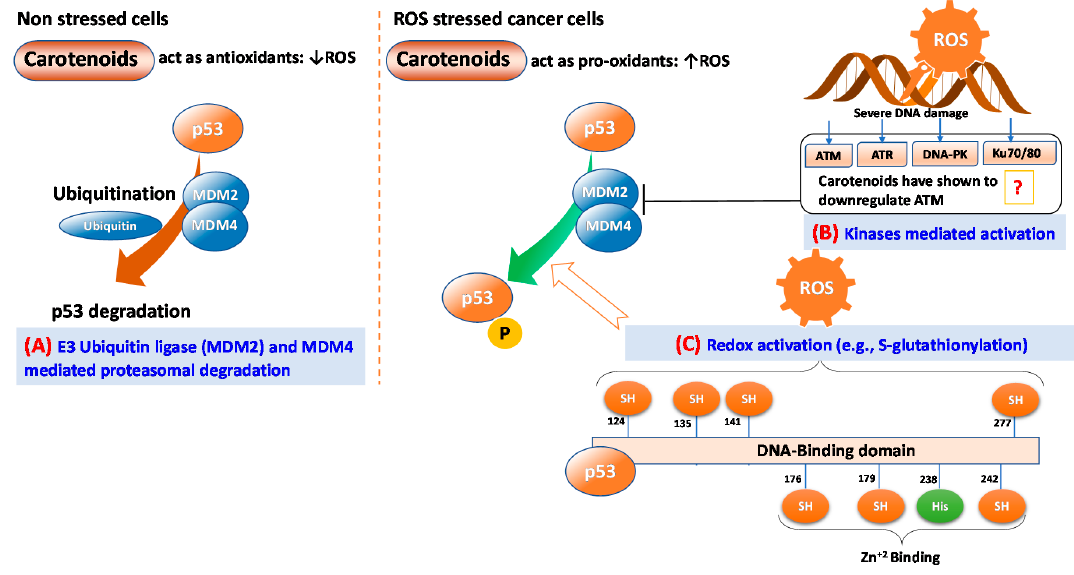
Figure 4. Major routes of p53 activation triggered by carotenoids-mediated reactive oxygen species (ROS)-induced. ( A ) E3 ubiquitin ligases MDM2 and MDM4 mediated proteasomal degradation in non-stress cells; ( B ) Kinases-mediated activation in cancer cells, and ( C ) Direct redox activation by S - glutathionylation of redox-sensitive cysteine residues at 124, 135, 141, and 277 of DNA-binding domain. ATM: ataxia telangiectasia mutated; ATR: ataxia telangiectasia and Rad3 related (a serine/threonine-protein kinase); DNA-PK: DNA-dependent protein